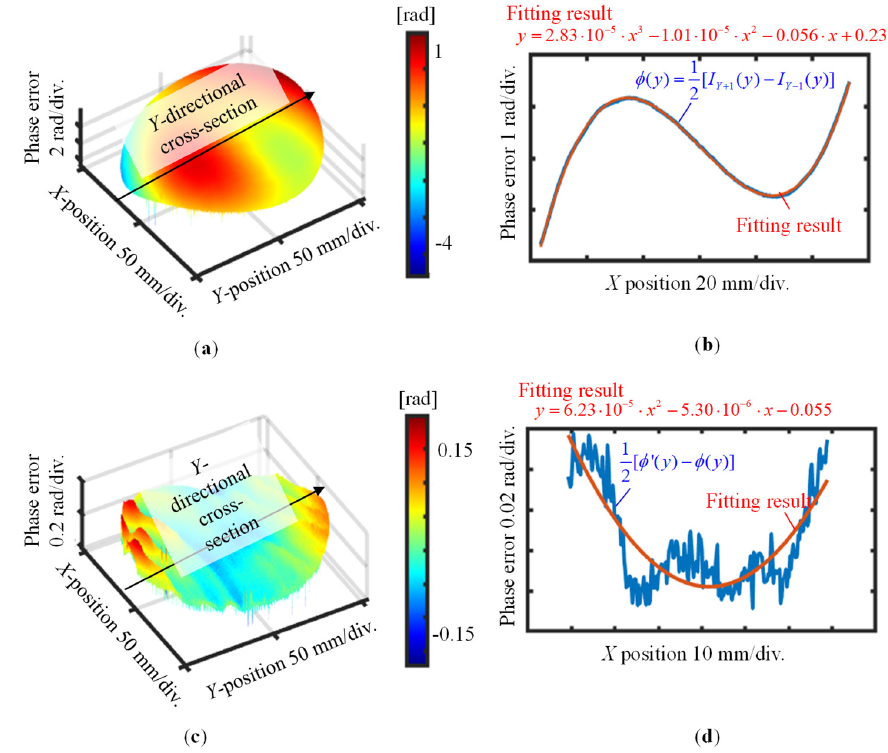
Figure 15. Measured first-order differential diffracted wavefronts before and after shift ( Y -direction): ( a ) Measured first-order differential diffracted wavefront before the shift; ( b ) Y -directional cross-sectional profile of the differential wavefront in (a); ( c ) Difference of the first-order differential diffracted wavefront before and after the shift; ( d ) Y -directional cross-sectional profile of the differential wavefront in ( c ).